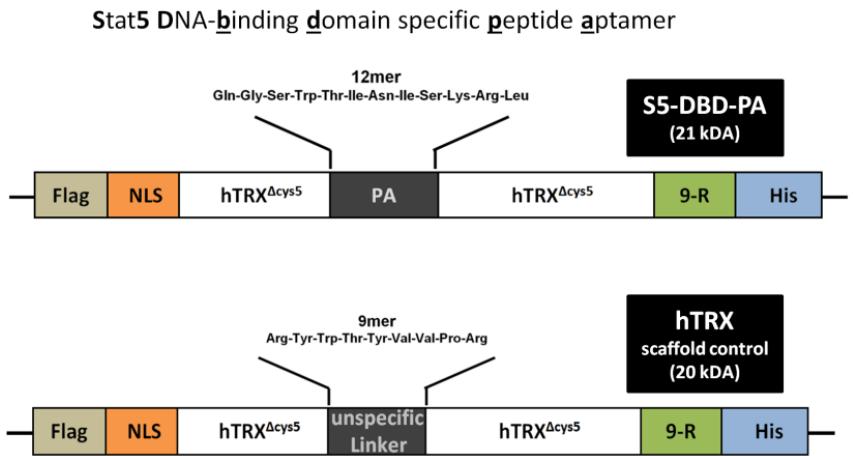
Figure 1. Design of the Stat5 specific peptide aptamer (PA) construct, S5-DBD-PA, a ligand of the DNA-binding domain of Stat5. The recombinant S5-DBD-PA protein comprise functional domains for its purification and transduction into target cells. The 12mer PA sequence, a specific interactor of the DNA-binding domain (DBD) of Stat5, is integrated in the active loop of the optimized hTRX Δcys5 scaffold protein, this provides for a constrained conformation of